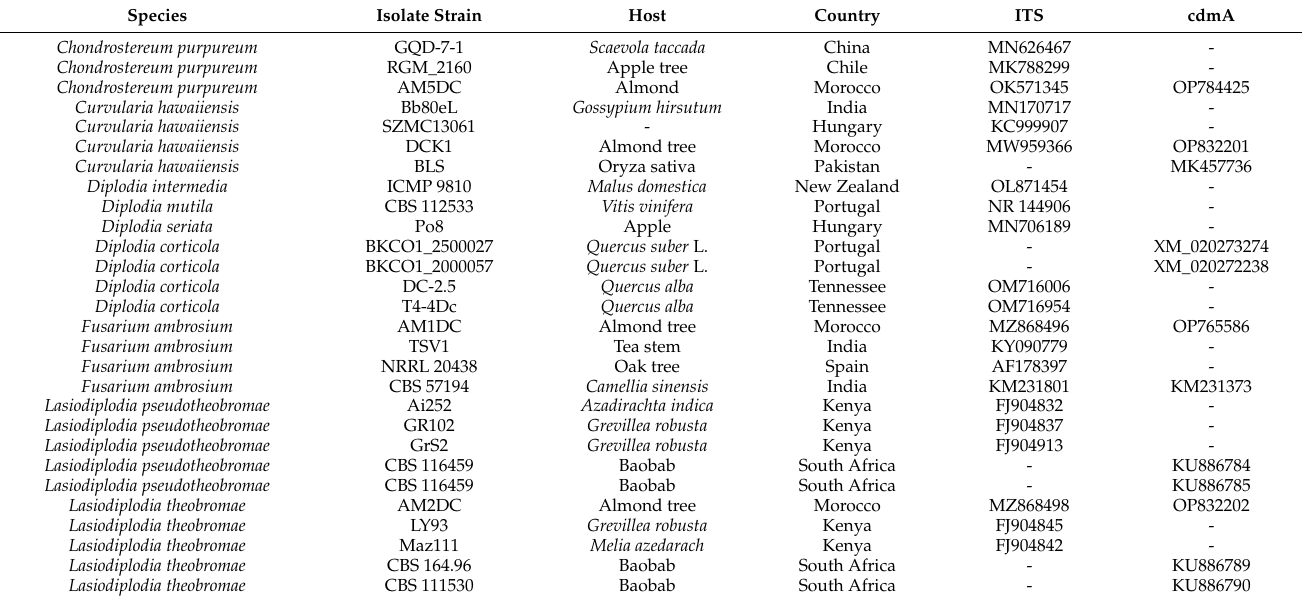
Table 1. Fungal isolates reported in this work and references used in the phylogenetic